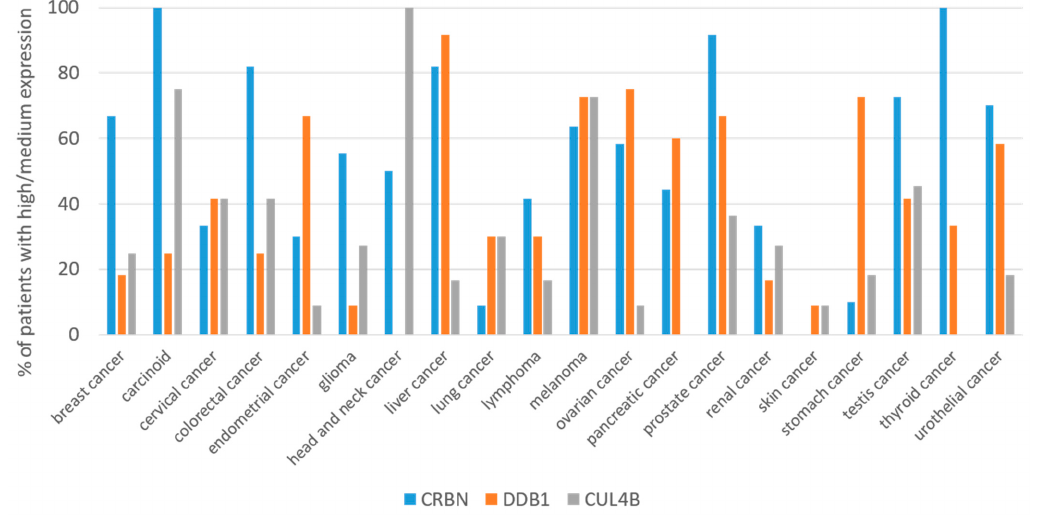
Figure 2. Expression of CRBN, DDB1 and Cullin 4B proteins in different cancer types. Fraction of patients with high/medium protein expression is shown. Data adapted from The Human Protein Atlas (https://www.proteinatlas.org/about/download; accessed on 20 October 2022).